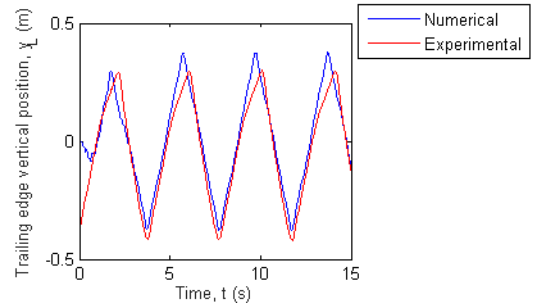
Fig. 7. Numerical and experimental results comparison of the time evolution of trailing edge vertical